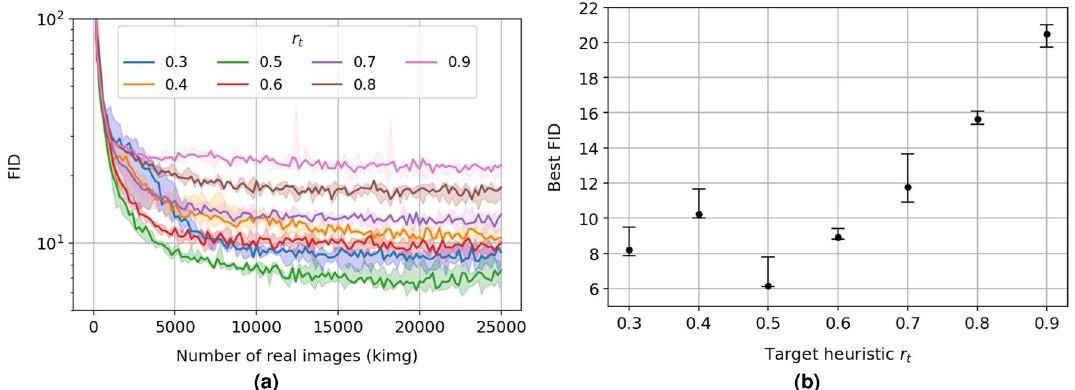
Figure 2. ( a ) Fréchet inception distance (FID, lower is better) of generated to real SEM images as a function of the number of real images (per thousand images, kimg) seen by the discriminator during the training of the StyleGAN2 for different heuristic r t ∈ { 0.3, 0.4, 0.5, 0.6, 0.7, 0.8, 0.9 } (blue, orange, green, red, violet, brown, and pink, respectively). For any distribution, the minimum, median, and maximum FID values issued from three independent runs are reported; ( b ) Corresponding median (black dot), minimum (lower cap), and maximum (higher cap) values for the best FID are shown for the different fixed r t